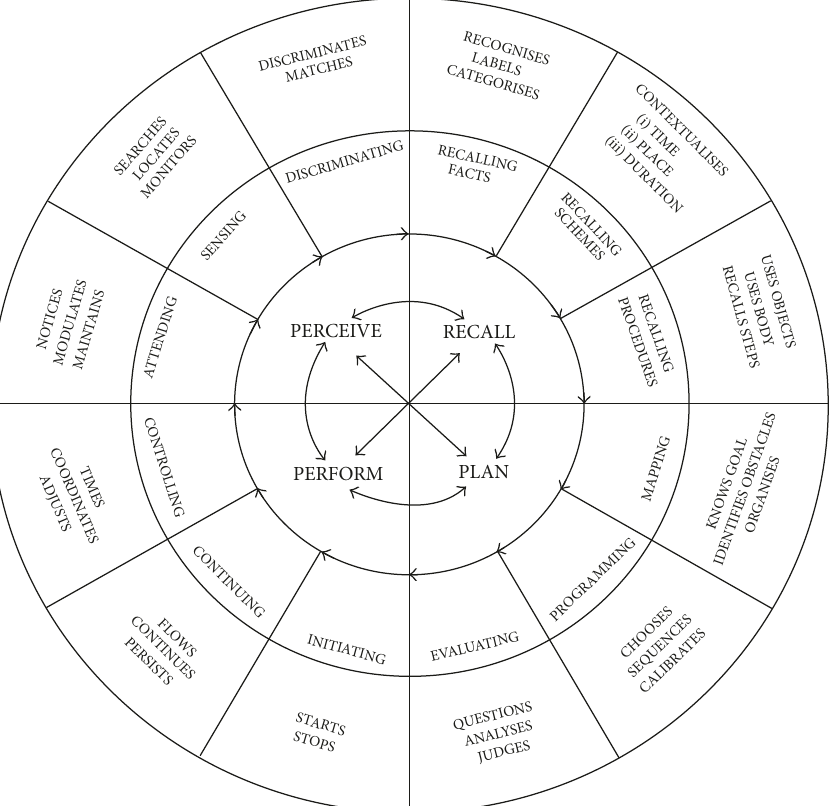
Figure 2: The PRPP System of Task Analysis: conceptual model of information processing behaviors [cited in